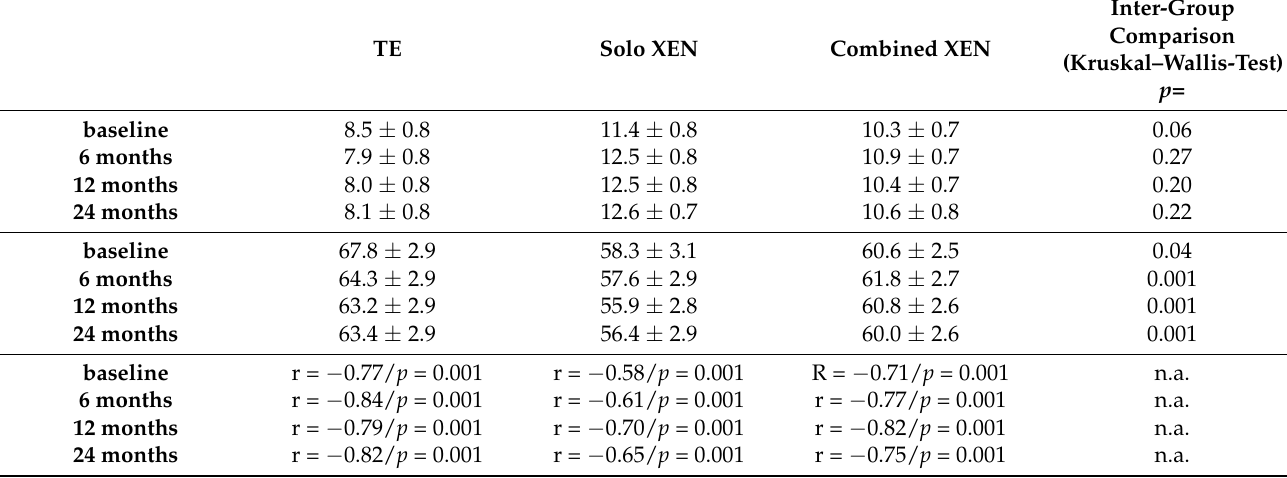
Figure 4. Development of RNFL thickness ( A ) and absolute change in RNFL thickness compared to baseline values ( B ) during 24 months of follow-up after surgery in the three treatment groups. Table 4. Results for mean defect of standard automated perimetry and mean global RNFL thickness in the three treatment groups over 24 months of follow-up after surgery. RNFL: retinal nerve fiber